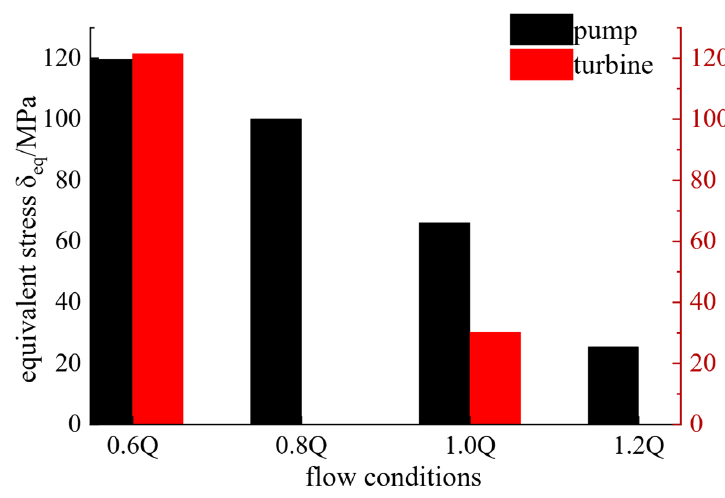
Figure 11. Stress under pump and turbine conditions.